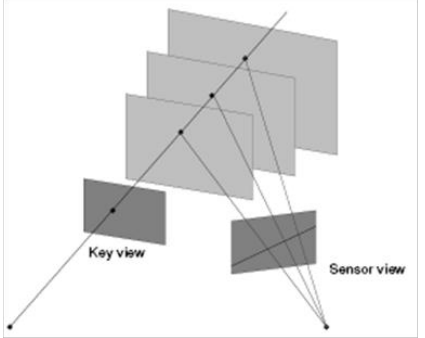
Figure 4: Plane sweeping principle. The homography between the facade’s reference plane and the sensor view varies for different depths. (Zach, 2007).